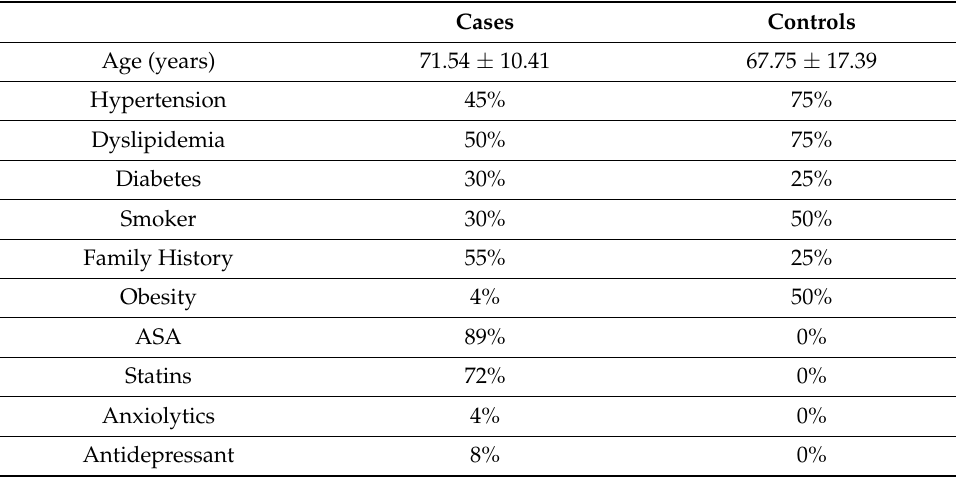
Table 1. Clinical and epidemiological characteristics of the patients included in this